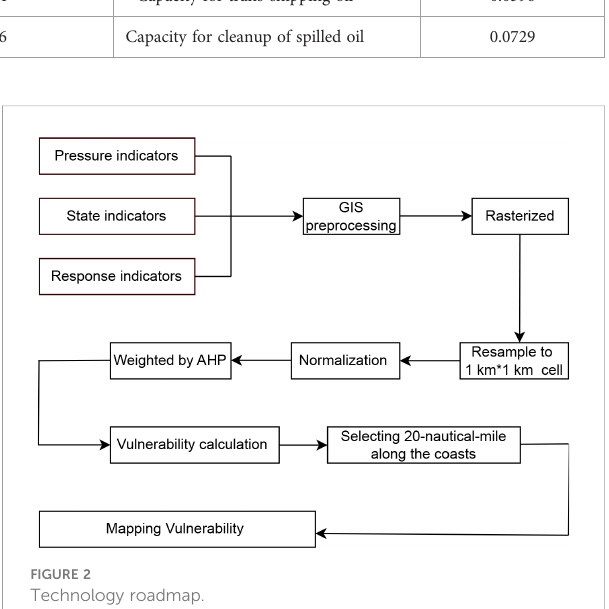
FIGURE 2 Technology